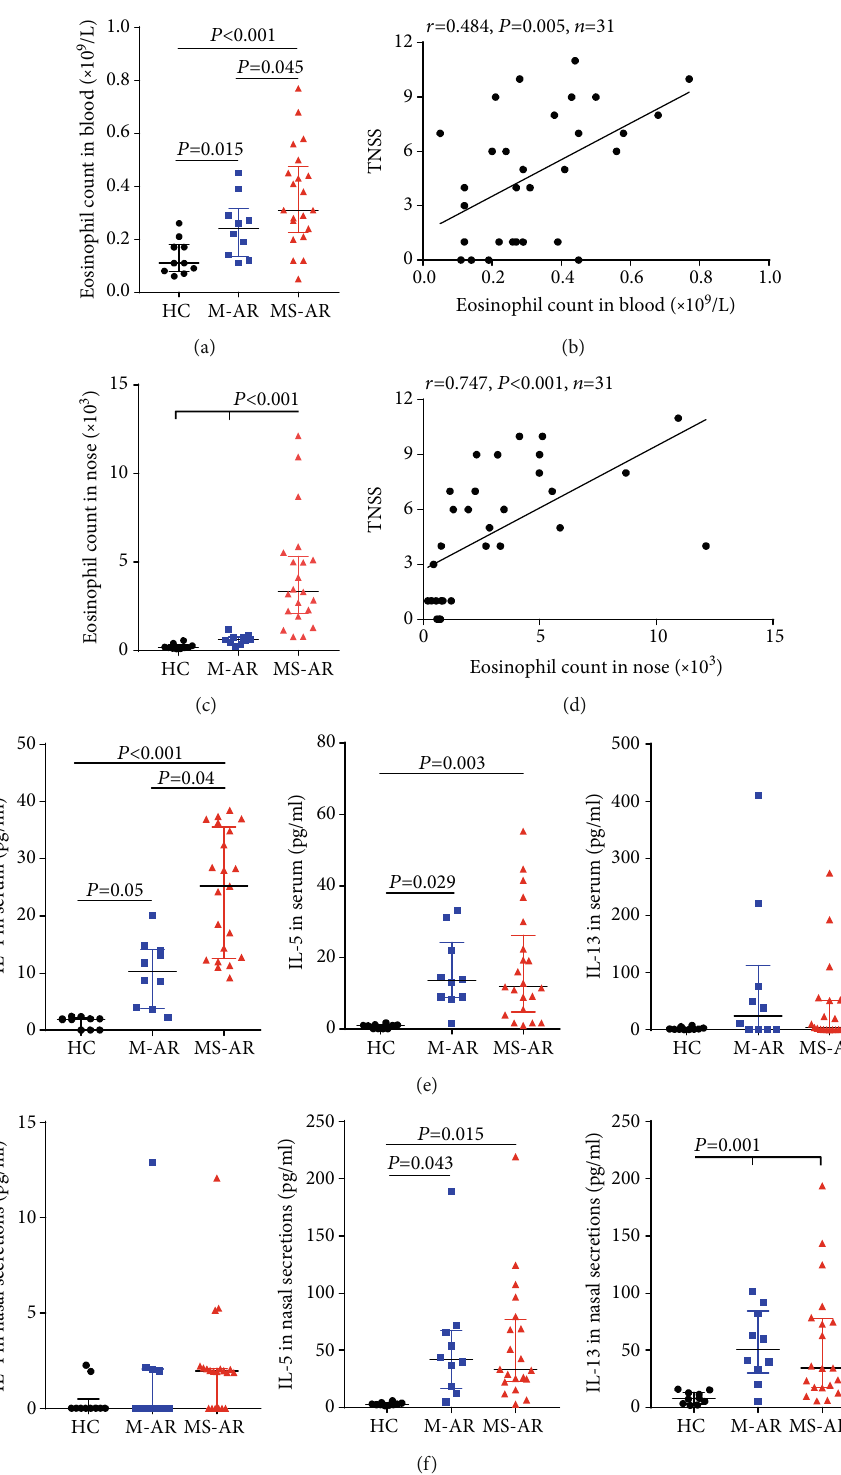
Figure 1: The clinical severity of allergic rhinitis correlates with the levels of eosinophils in the blood and nose. Eosinophil count in the peripheral blood (a) and nose (nasal brushing) (b) of healthy controls, mild allergic rhinitis, and moderate-severe allergic rhinitis. Positive correlation of TNSS with the blood (b) and nasal (d) eosinophil counts in allergic rhinitis. Levels of Th2-related cytokines IL-4, IL-5, and IL-13 in the peripheral blood (e) and nasal secretions (f) of healthy controls and mild and moderate-severe allergic rhinitis. HC: healthy controls; M-AR: mild allergic rhinitis; MS-AR: moderate-severe allergic